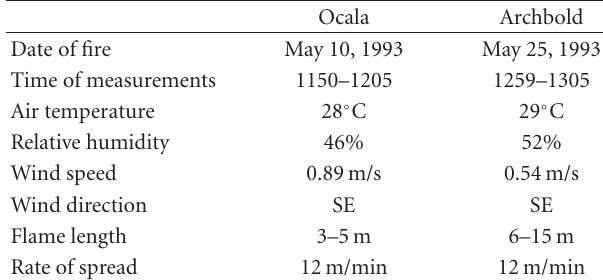
Table 1: Weather conditions and fire characteristics for Florida sand pine scrub fires at Ocala National Forest and Archbold Biological Station during May